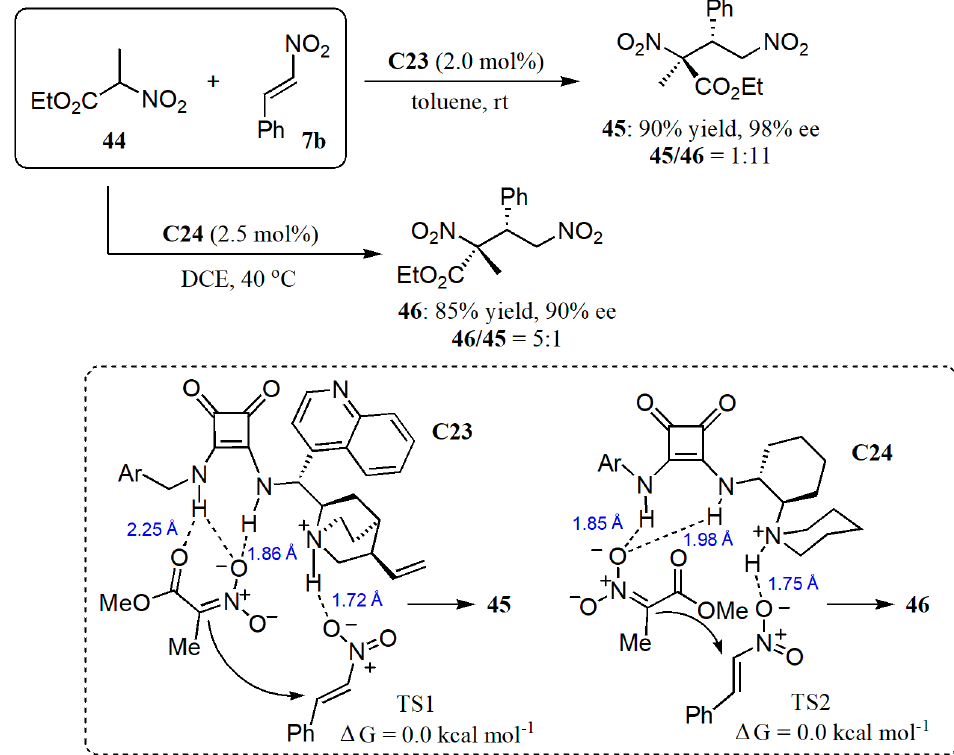
Figure 31. Model of the initial diastereo-divergent Michael addition in the cascade reaction leading to functionalized cyclohexanes 42 and 43 and TSs leading to the major products 45 and 46 determined by DFT calculations [64].